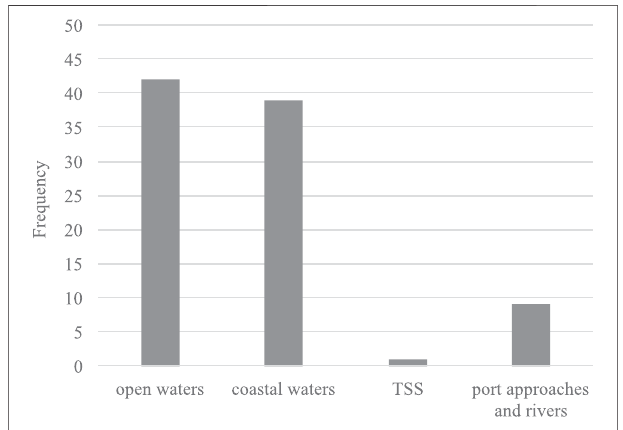
FIGURE 4 | Bar chart of the targeted or inferred area of operation of the proposed approaches.